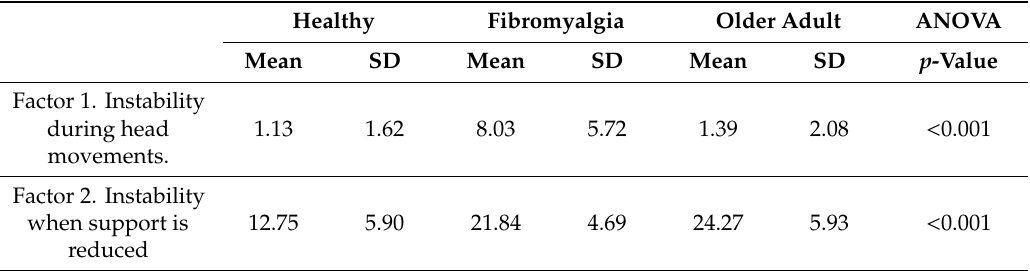
Table 8. Between-group di ff erences in factor components of the 20-item JAEN screening tool. Healthy Fibromyalgia Older Adult ANOVA Mean SD p